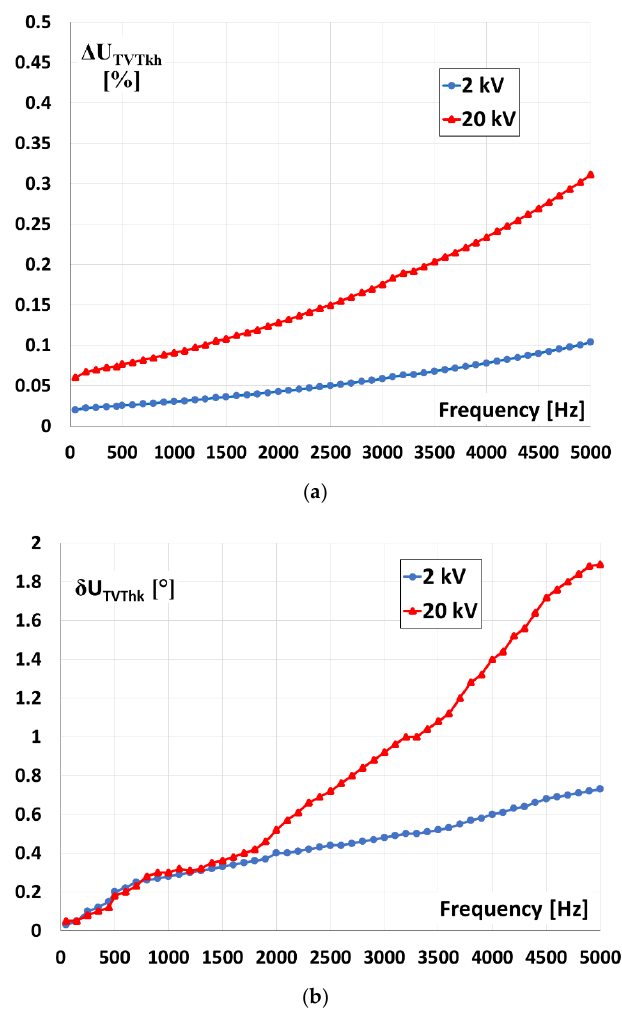
Figure 5. Voltage ratio error ( a ) and phase displacement ( b ) of used 2 kV and 20 kV (15 V) voltage dividers determined for sinusoidal voltage 200 V. The results obtained for the voltage divider with its input voltage equal to 15 kV are very similar to those presented for its 20 kV input. Taking into consideration the measurement uncertainty, the values of voltage ratio error and phase displacement of the voltage divider with the input voltage equal to 2 kV are 0.05%/ 0.1 for 50 Hz and increase to 0.5%/ 1.0 for 5 kHz. In the case of the voltage divider with input voltages equal to 20 kV and 15 kV it is 0.1%/ 0.1 for 50 Hz and increase to 1.0%/ 2.5 for 5 kHz. The measurement uncertainty of the differential measuring system used for evaluation of the values of voltage ratio error and phase displacement of tested VTs for transformation of distorted voltage’s harmonics ( Figure 4) is analysed in detail in the paper [25]. 5. The Results of Evaluation of the Transformation Accuracy of the Slow-Front Transient Overvoltages Figure 6 shows the voltage waveform used for evaluation of the transformation accuracy of the slow-front transient overvoltages by inductive VTs. Their properties are